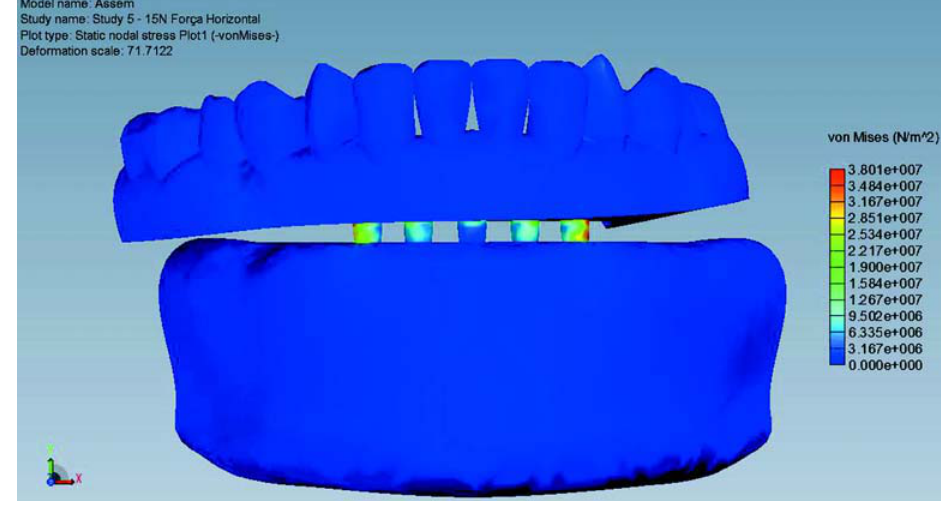
FIGURE 3- Bilateral balanced occlusion